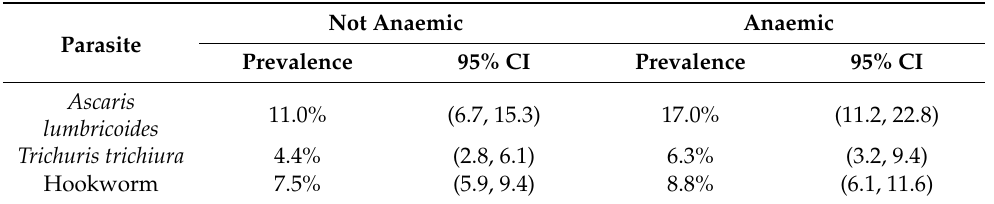
Table 1. Prevalence of soil-transmitted helminthiases in school-aged children classified according to their anaemia status in Burundi,